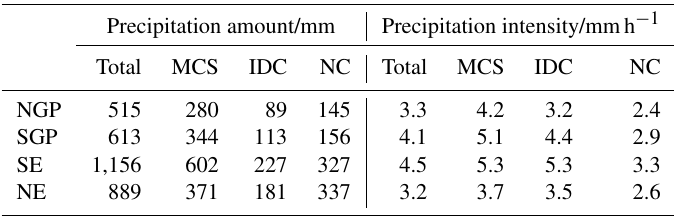
Table A6. Annual mean precipitation amounts and intensities for different types of precipitation in different regions of the US for 2004–2017 by using the new MCS